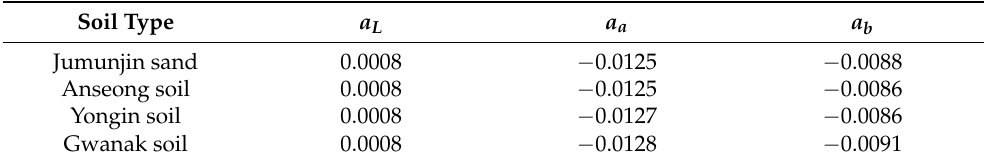
Table 3. Slope of linear regression lines between lighting conditions (illuminance and color tempera- ture) and CIELAB-based soil